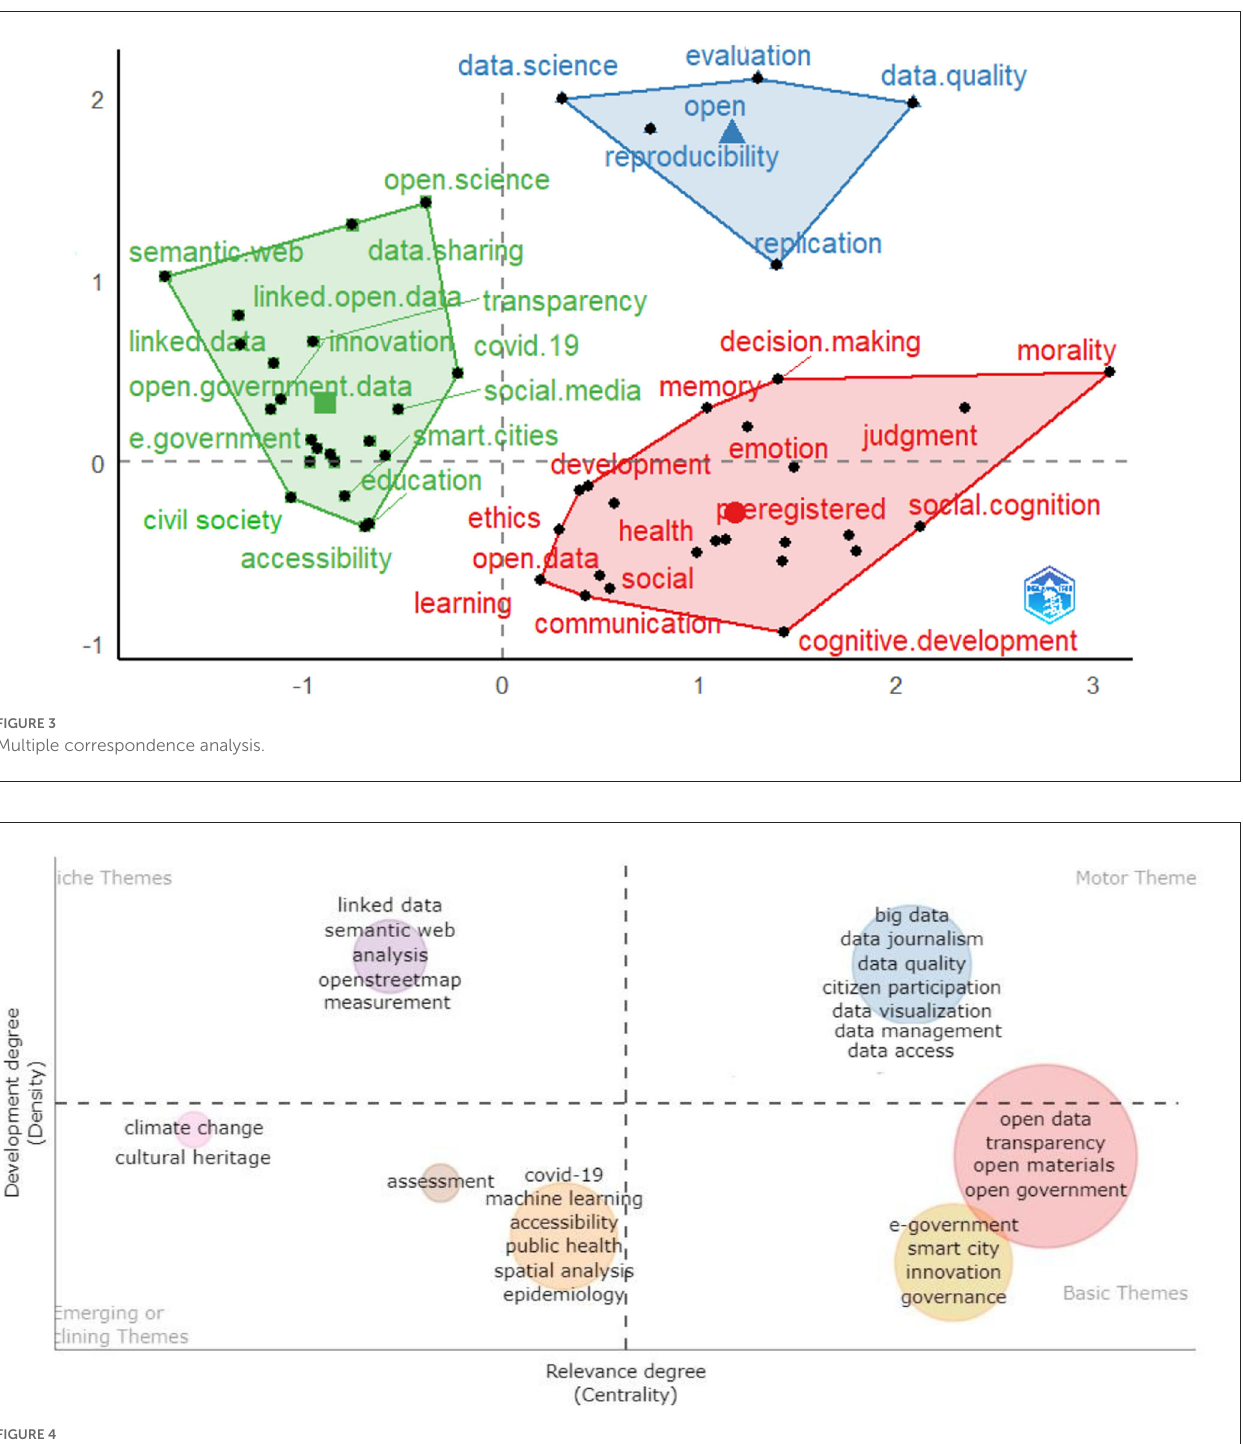
FIGURE4 Thematic